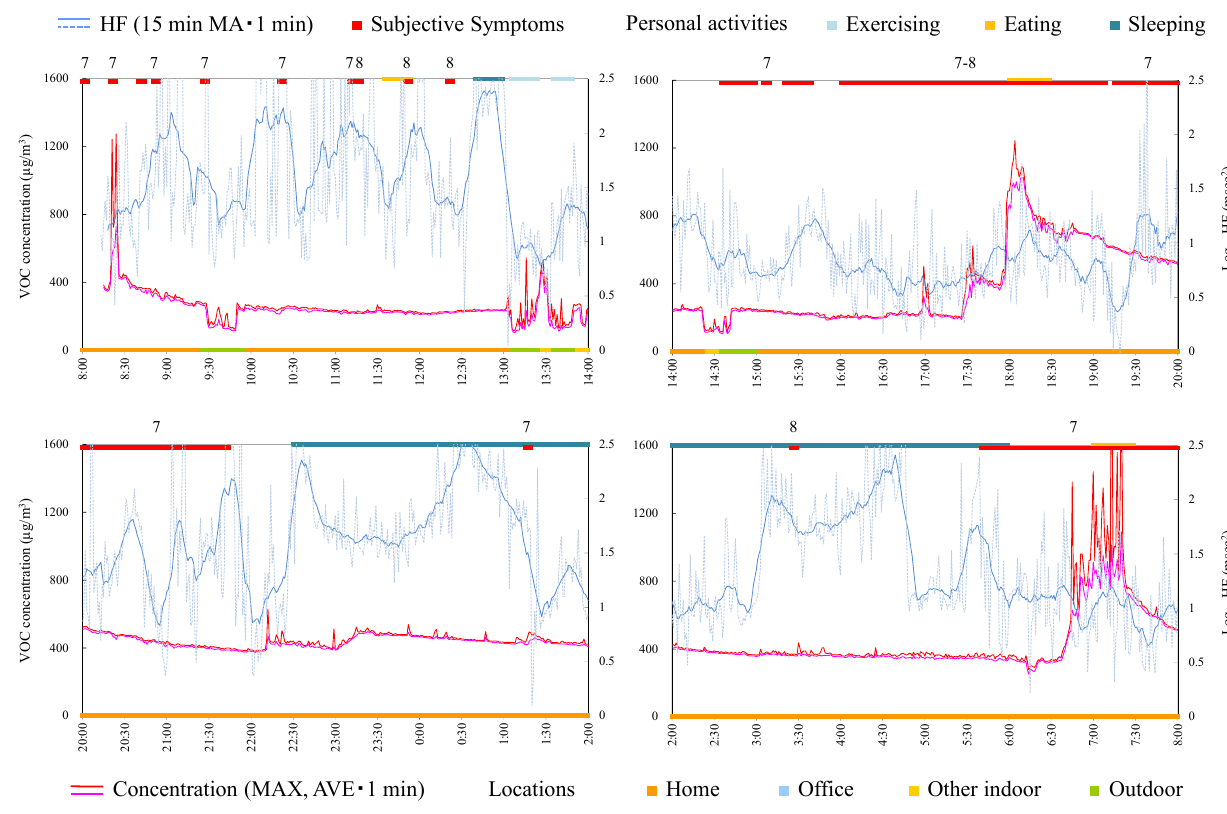
Figure 4. Time-series data of VOC concentration and log 10 HF (subject B). Subjective symptoms and personal activities are indicated in upper side and locations are indicated in lower side. The values on subjective symptoms are symptom